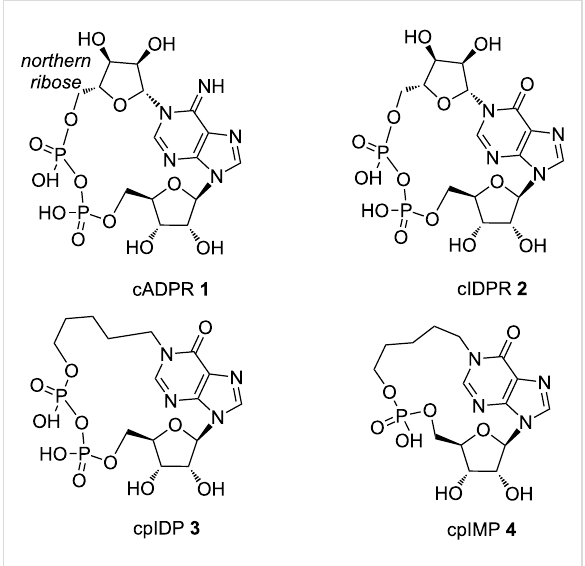
Figure 1: Structures of cADPR ( 1 ), cIDPR ( 2 ), cpIDP ( 3 ) and cpIMP ( 4